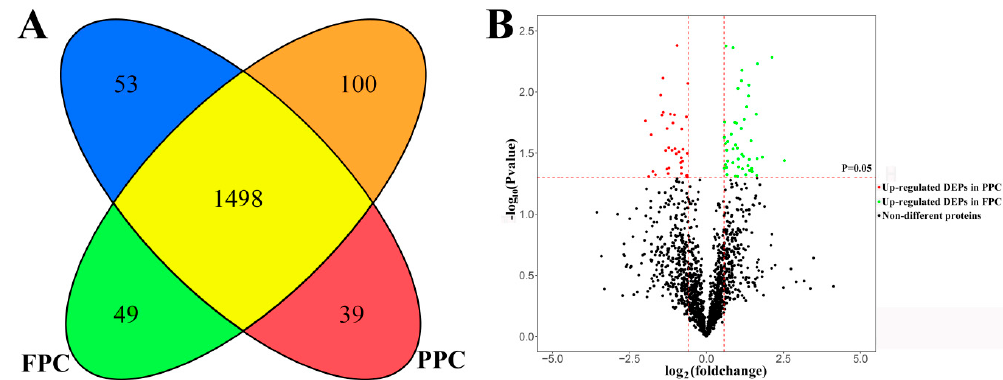
Figure 1. Summary of liquid chromatography–mass spectrometry (LC–MS/MS) results. ( A ) A